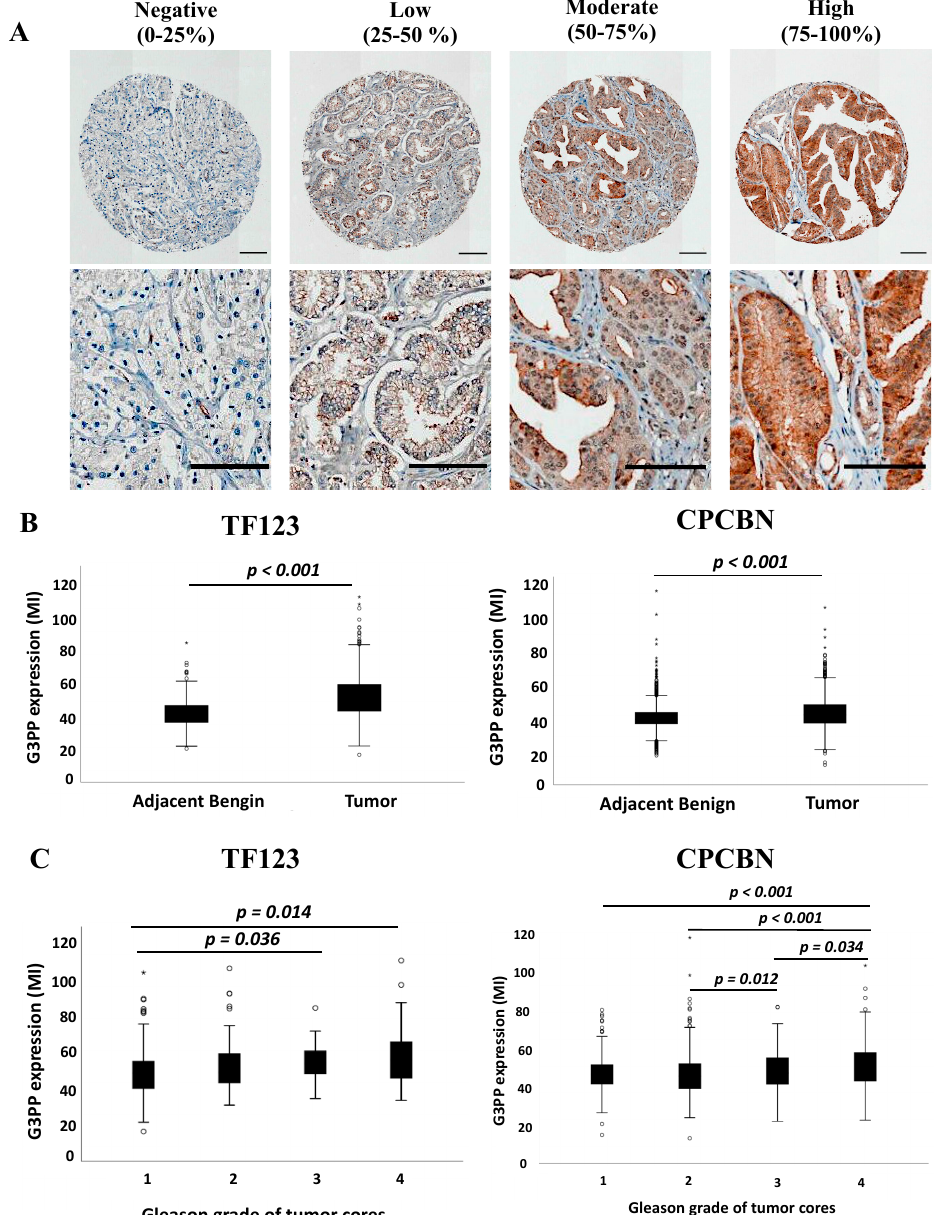
Figure 1. Epithelial expression of glycerol 3-phosphate phosphatase (G3PP) in prostate cancer tissues. ( A ) Representative images of G3PP immunostaining on tissue micro array (TMA) cores of prostate cancer. Images represent expression of G3PP protein at less than the 25th percentile, between the 25th and 50th, between 50th and 75th, and more than 75th percentile. Scale bars, 200 µm (top) and 50 µm (bottom). ( B ) Box-plot representation of epithelial expression of G3PP in prostate cancer tissues versus benign adjacent tissues of the TF123 and CPCBN tissue micro arrays (TMAs) (p-value, Mann–Whitney U test) and ( C ) box-plot representation of epithelial expression of G3PP in prostate cancer tissues in the different Gleason score categories (1, 2, 3, or 4) ( p -value, Kruskal–Wallis test).